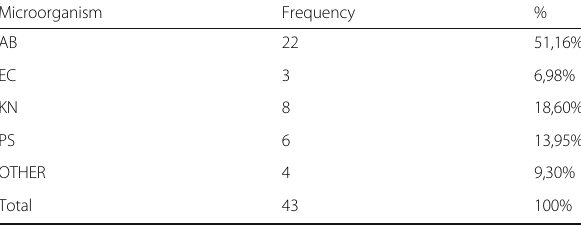
Table 2 (abstract 0158). The most frequent bacteria founded